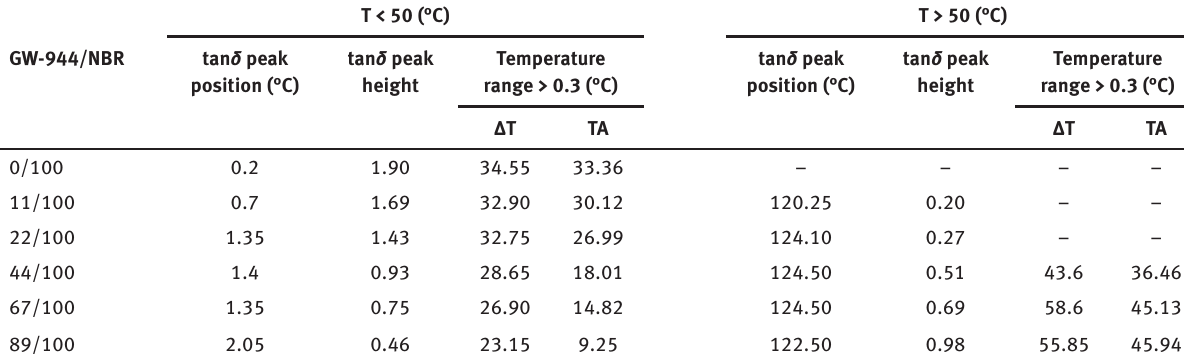
Table 2: Damping properties of the GW-944/NBR composite with different GW-944 molecule contents.